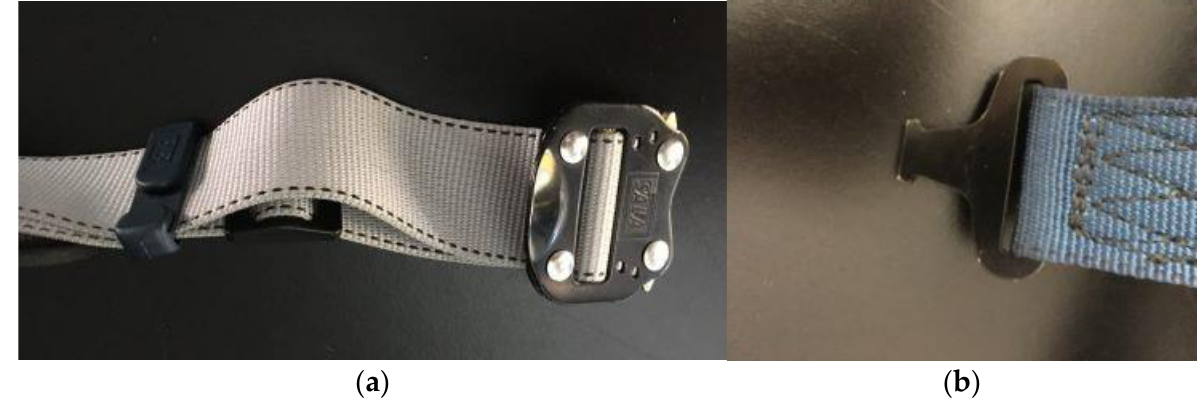
Figure 1. The leg-strap connection: ( a ) adjustable insertion end and ( b ) hook end. Photo by Roger Jensen.